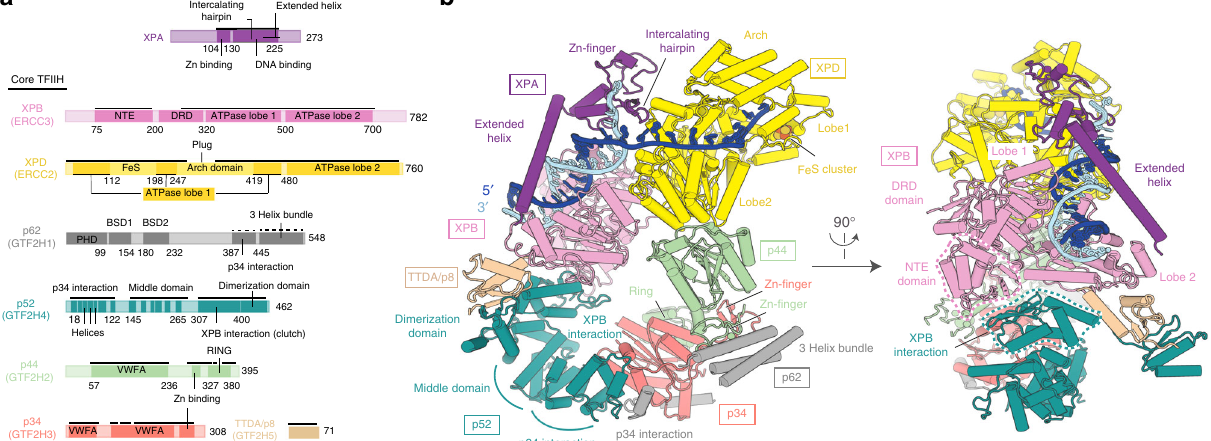
Fig. 2 Structure of human core transcription factor IIH (TFIIH)-XPA-DNA complex. a Domain organization of XPA and human TFIIH subunits. Residues at domain borders are indicated. Solid and dashed black lines mark residues modeled as atomic and backbone structures, respectively. DRD damage recognition domain, NTE N-terminal extension, BSD BTF2-like, synapse-associated and DOS2-like domains, VWFA von Willebrand factor type A domain. b Cylindrical representation of the structure. Proteins colored as in a . Newly built XPB and p52 domains are highlighted with dashed lines and reveal how XPB is connected to the TFIIH